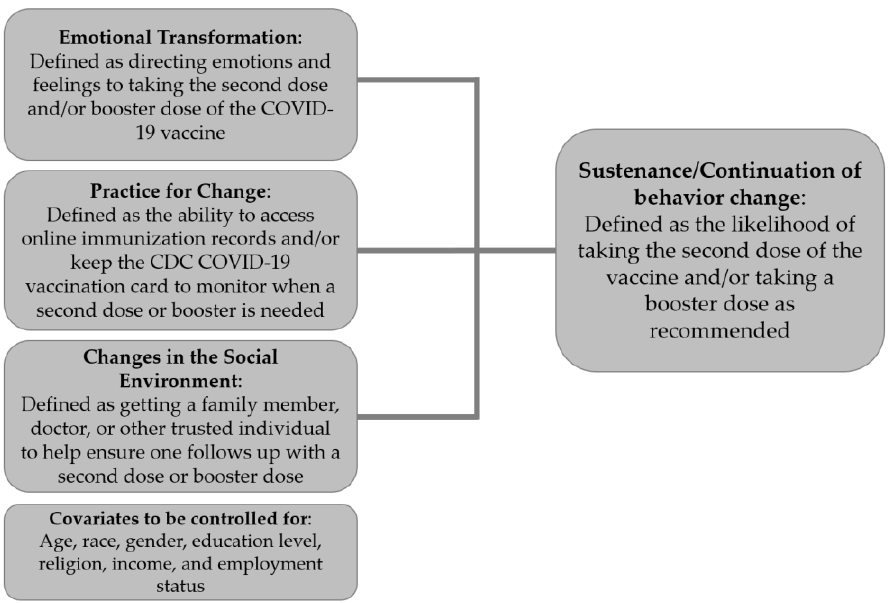
Figure 2. Constructs in the sustenance of health behavior change in the Multi-Theory Model of health behavior change.